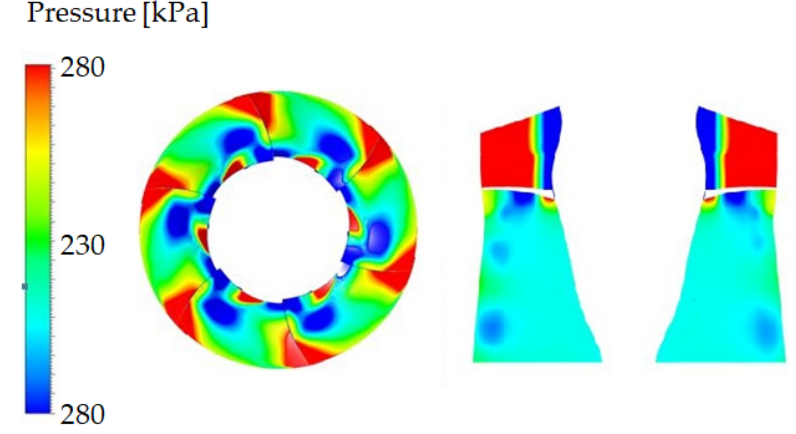
Figure 9. Numerical absolute pressure contours in the runner domain.